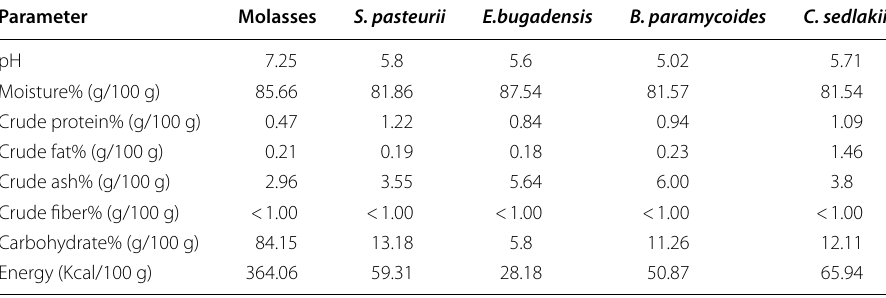
Table 3 Proximate analysis of diluted molasses substrate and bioenzymes Parameter Molasses S. pasteurii E.bugadensis B. paramycoides C. sedlakii